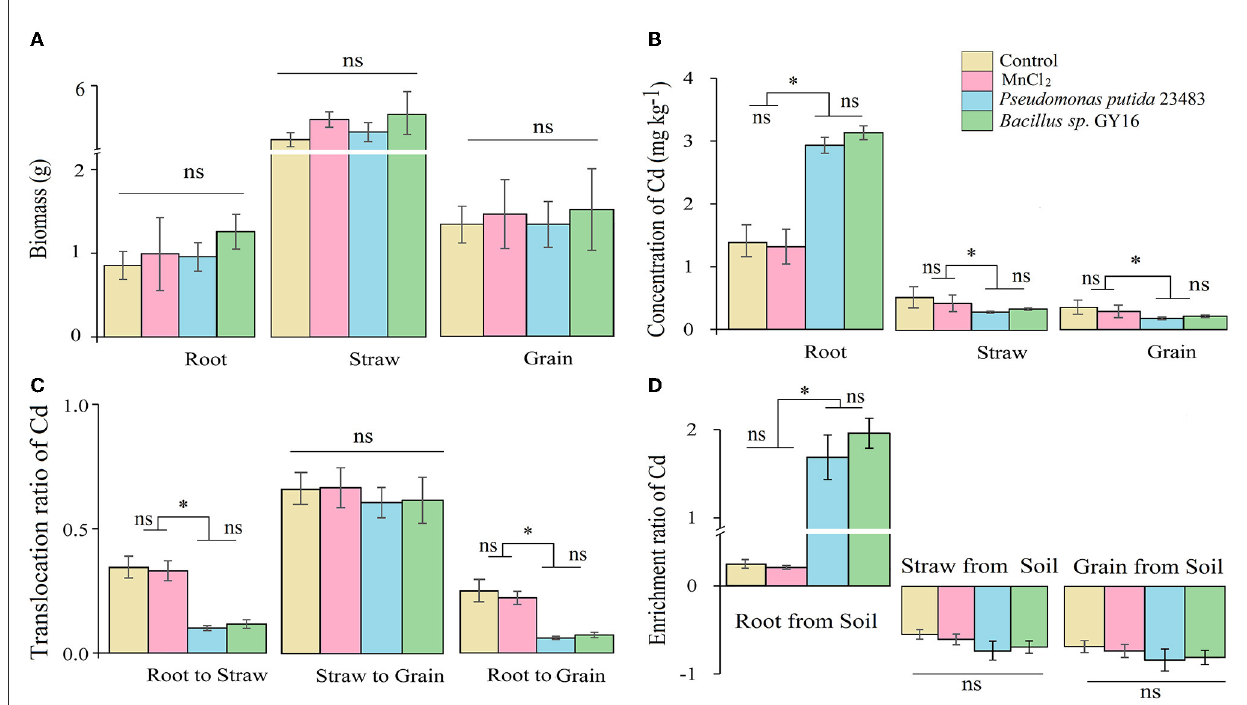
FIGURE4 Biomass (A) , concentrations of Cd in root, straw, and grain (B) , the transmission ratio of Cd from root to straw and grain, (C) and enrichment ratio (D) without or with inoculation of microbial strains Pseudomonas putida 23483 and Bacillus sp. GY16. Bars with an asterisk (*) indicate significant differences among treatments determined by Tukey’s HSD test at P < 0.05, and “ns” means not significant.